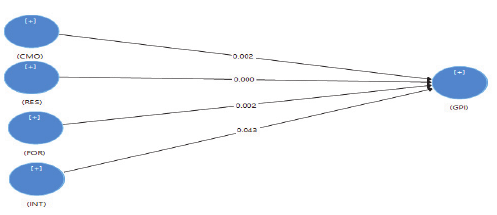
Fig. 2. PLS Algorithm for Hypothesis Testing